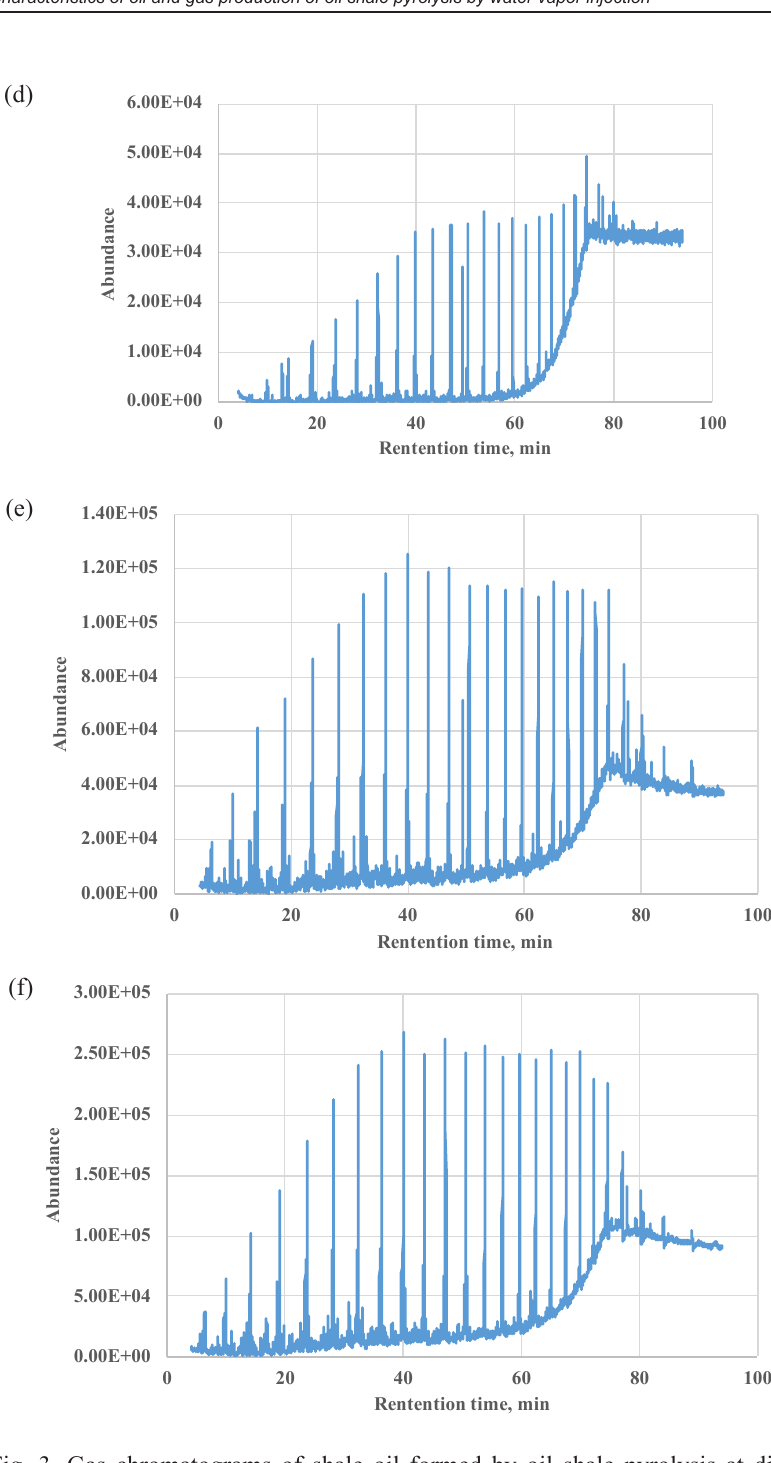
Fig. 3. Gas chromatograms of shale oil formed by oil shale pyrolysis at different temperatures: (a) 300 °C; (b) 350 °C; (c) 400 °C; (d) 450 °C; (e) 500 °C; (f) 550